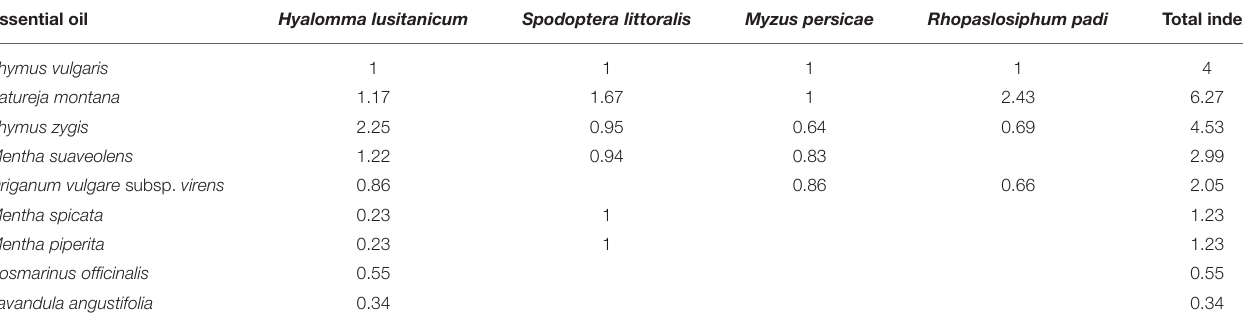
TABLE 4 | Rank index [calculated as EC 50 of Thymus vulgaris essential oil (EO)/EC 50 of ranked species’ EO] of the bioactive EO-producing plant species tested for further selection. Essential oil